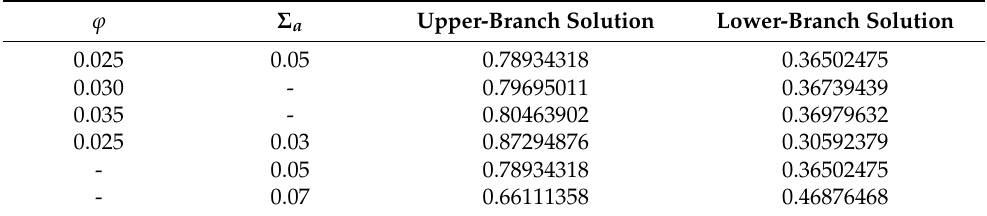
Table 4. Quantitative values of the friction factor for the upper and lower solution branches with several values of ϕ and Σ a when Pr a = 1.0, Sc a = 10.0, Pr = 6.2, ε a = − 1.2, and γ s = 0.5. ϕ Σ a